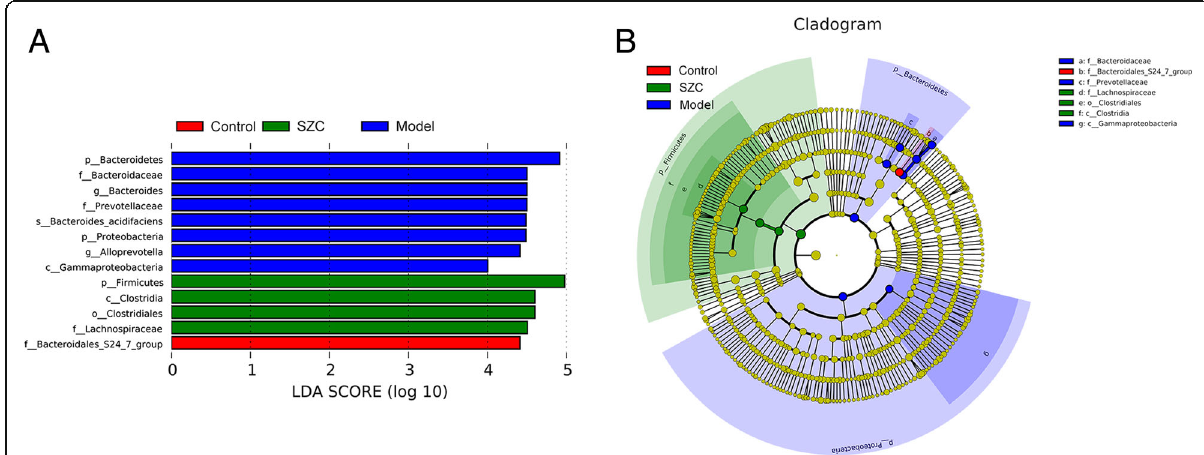
Fig. 5 Statistical difference in dominant microbiota among groups (n = 5, male/femal = 2 – 3). ( a ) The histogram of LDA value distribution. ( b ) The evolutionary branch